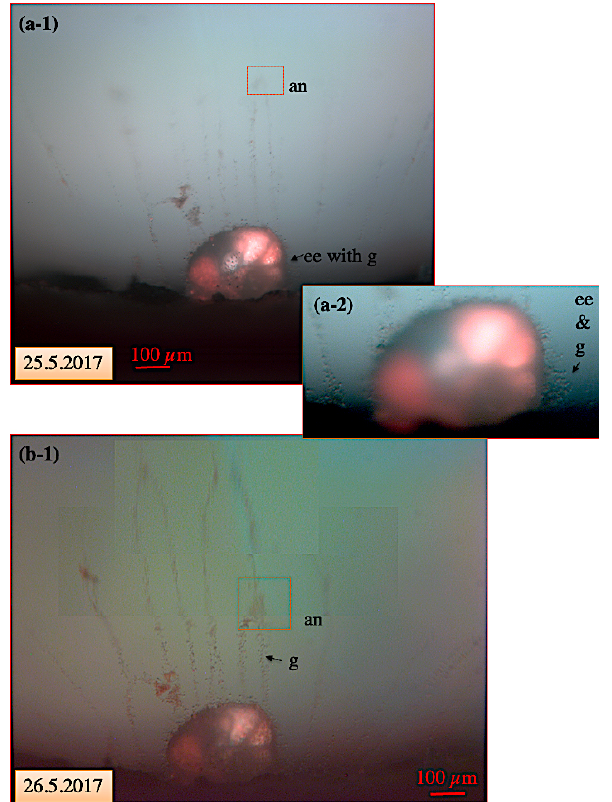
Figure 10. Pseudopodial network of C. pachyderma specimen 1 under fluorescent light on 25 and 26 May. Movement of an anasto- mosis within 24h after feeding. (a-1) In the course of the exper- imental running time, a visually increasing amount of algae (in- tensified red colour of cytoplasm; compare to Fig. 9) had accu- mulated in the specimen’s cytoplasm. A red square indicates the position of a slowly moving anastomosis in the pseudopodial net- work. Panel (a-2) shows the test at higher magnification revealing the presence of numerous granules in the ectoplasmic envelope and twigs. (b) Twenty-four hours later, the anastomosis had moved by approximately 150µm towards the shell. “an” denotes anastomosis; “ee” denotes ectoplasmic envelope; “g” denotes granule.